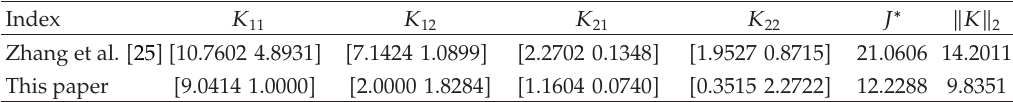
Table 1: Comparison of fuzzy controller, for example, with Zhang et al. (cid:6) 25 (cid:7)